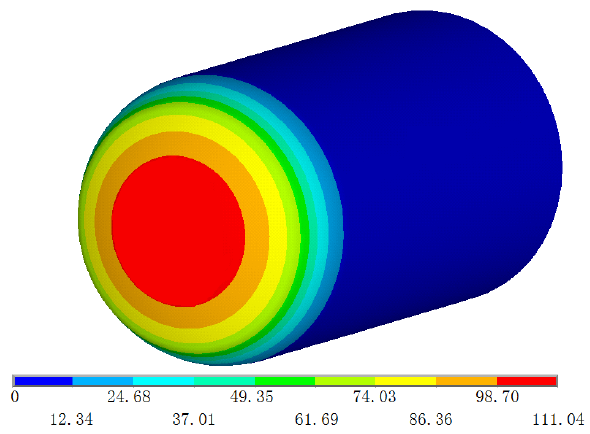
Figure 7. Aircraft temperature field.